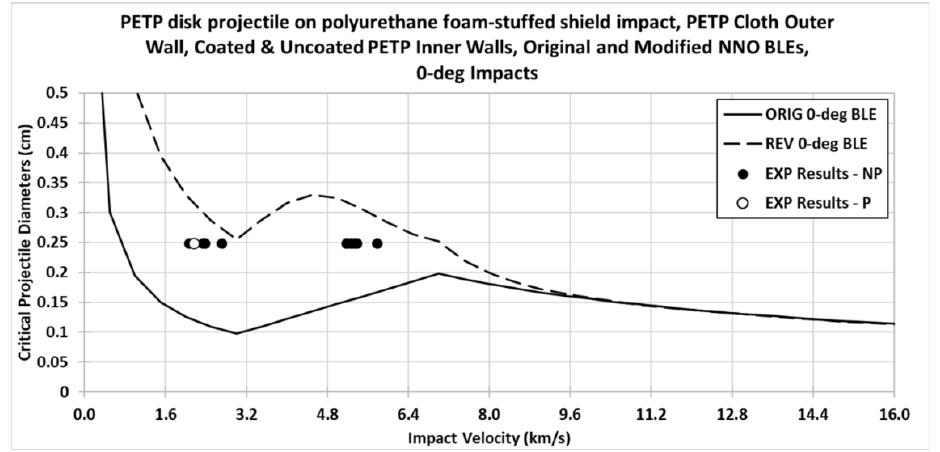
Figure 2. Comparison of Original and Modified NNO BLEs against P/NP data in [8] for Dual-Wall Systems with PETP Outer Walls and PETP Inner Walls.